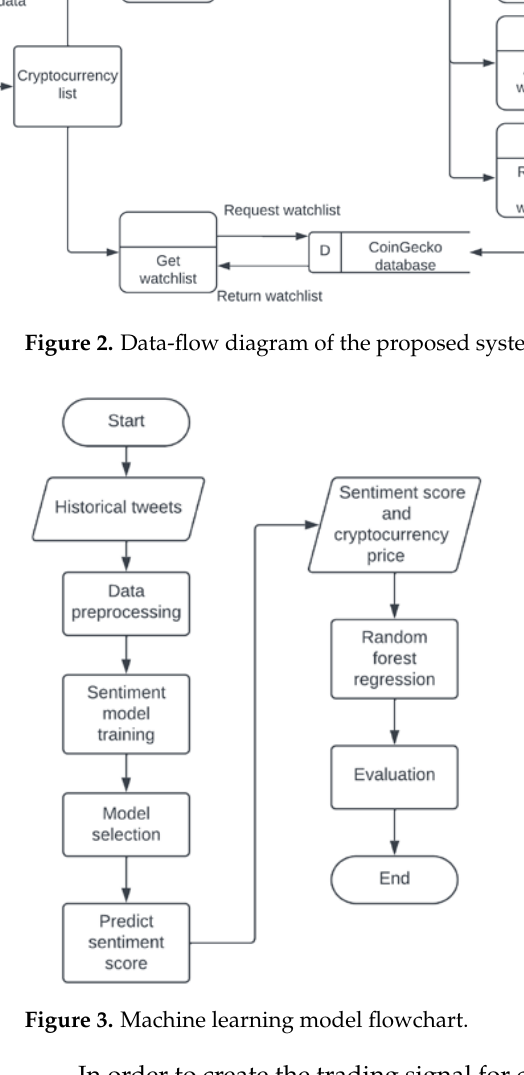
Figure 4. March 2022 percentage change of Bitcoin price. All the signal results calculated above are sent to the prediction API server, thereby allowing the system to obtain predicted signals by posting a request.